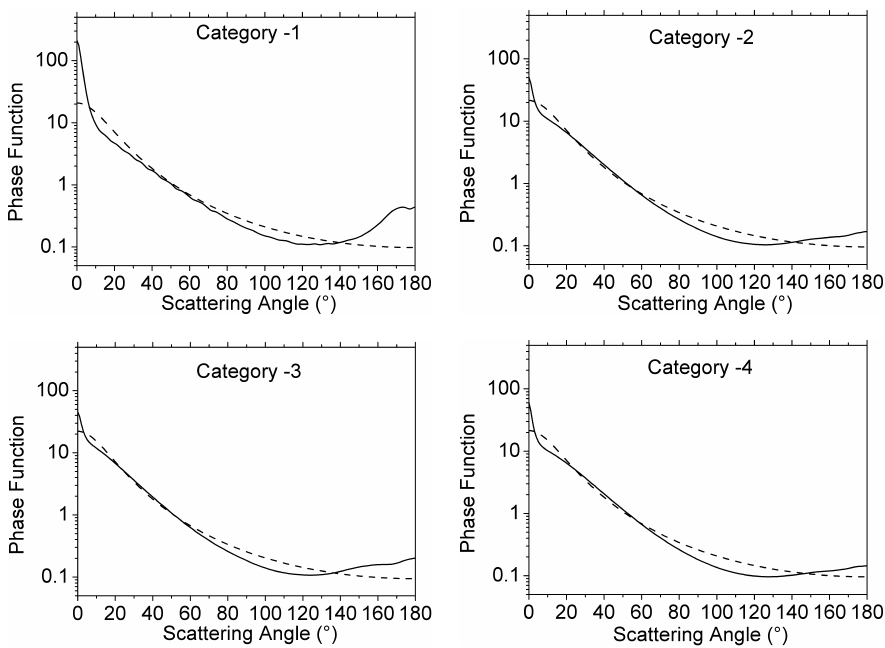
Fig. 5. Mie phase function (solid line) compared with Henyey-Greenstein phase functions (dashed line) for wavelength=0.47µm.